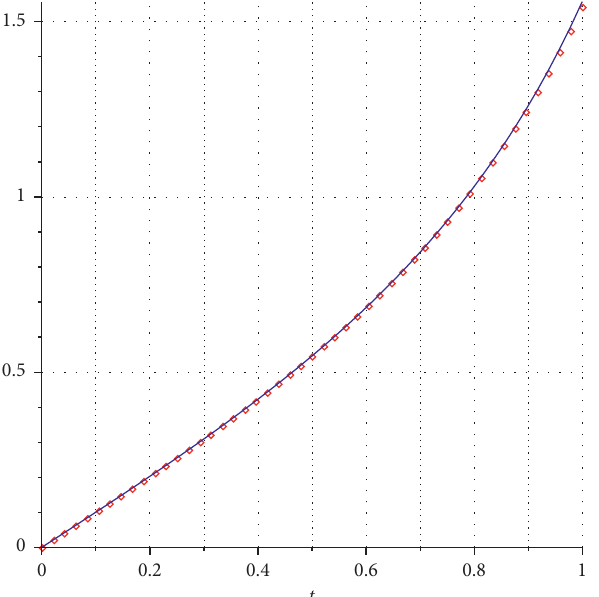
Figure 2: Comparison of the exact solution (blue) and the ap- proximate solutions (red) of Example 2.